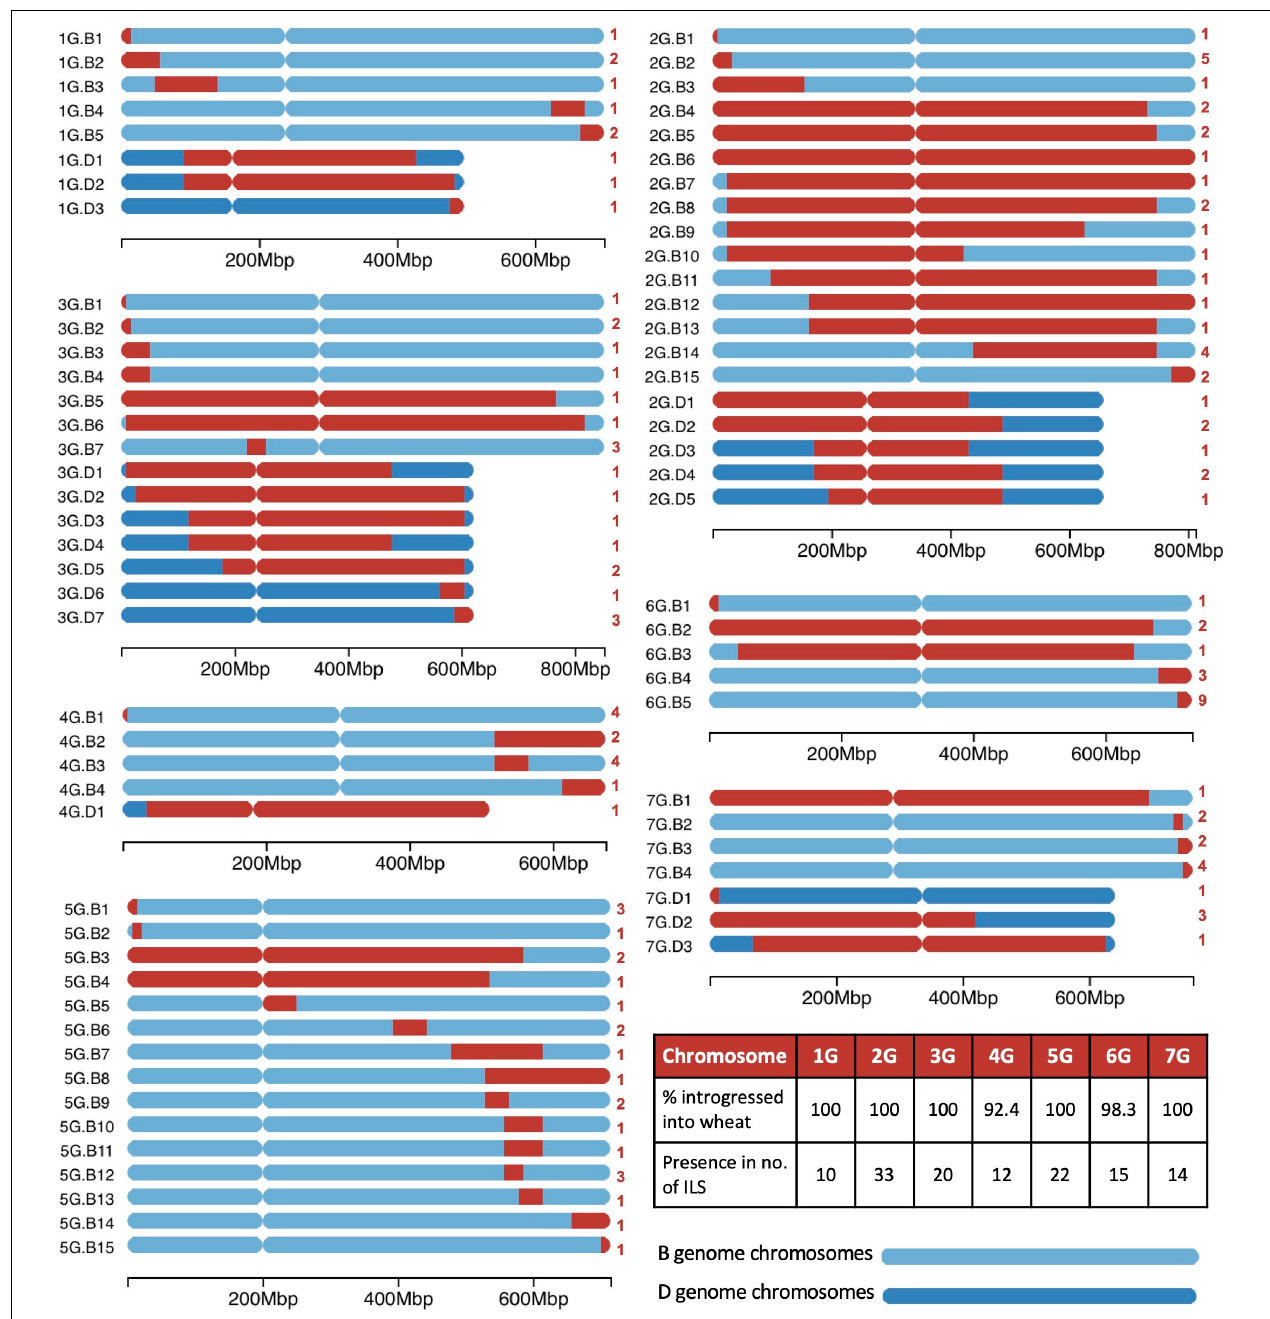
FIGURE 4 | A graphical representation of the size and location of unique introgressions from the G genome of Triticum timopheevii (red) in wheat B and D genome chromosomes (shades of blue) for each of the seven linkage groups. On the left of each ideogram is the label of each unique introgression and on the right is the number (in red) of introgression lines (ILs) the segment is found in. A table on the bottom right shows the percentage of each G chromosome that has been introgressed into the wheat genome and the number of ILs that contains a homozygous segment from each of the G chromosomes. A scale at the bottom of each linkage group shows the size of the